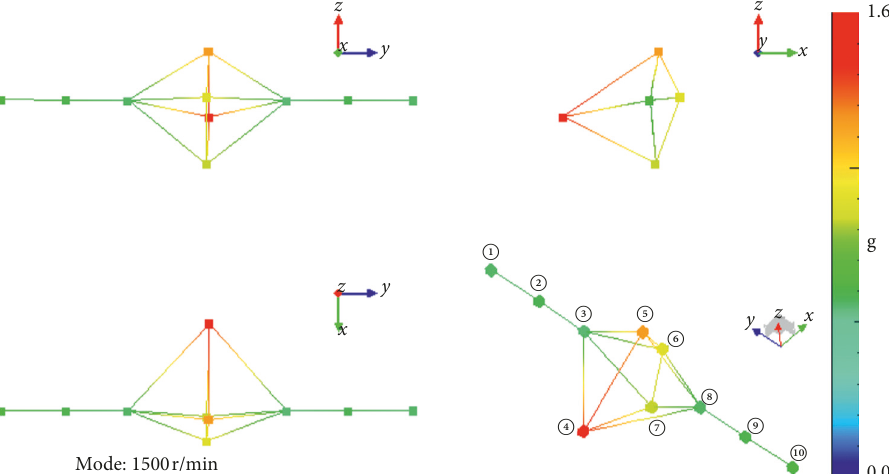
Figure 11: Operational deflection shape of rear axle at engine speed 1500r/min.